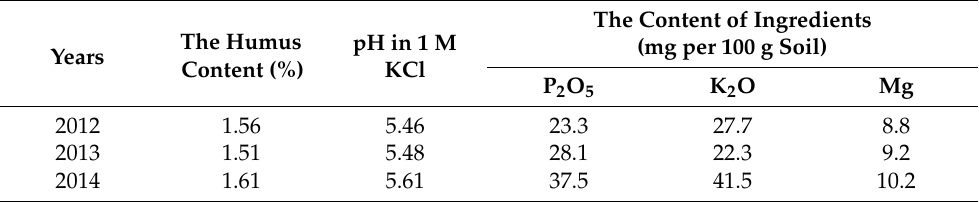
Table 1. Selected chemical properties of the soil in a layer of 0–30